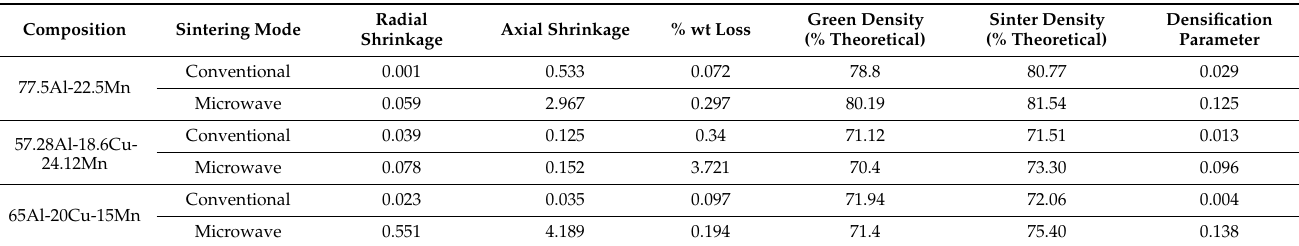
Table 3. Effect of compaction pressure and sintering on the densification response of Al-alloys compacted at 400 MPa and sintered at 550 ◦ C.